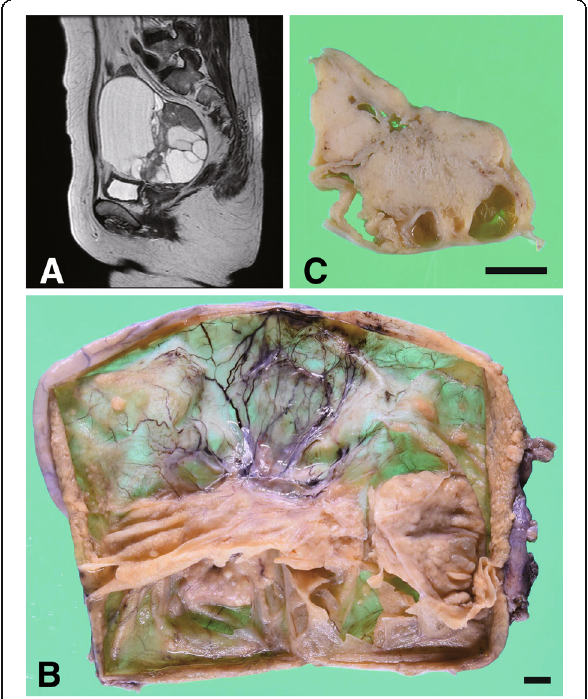
Fig. 1 Overview of the ovarian cancer. a Representative sagittal view of magnetic resonance imaging. The inside ( b ) and cut surface ( c ) of the ovarian tumor. Black bars: 1